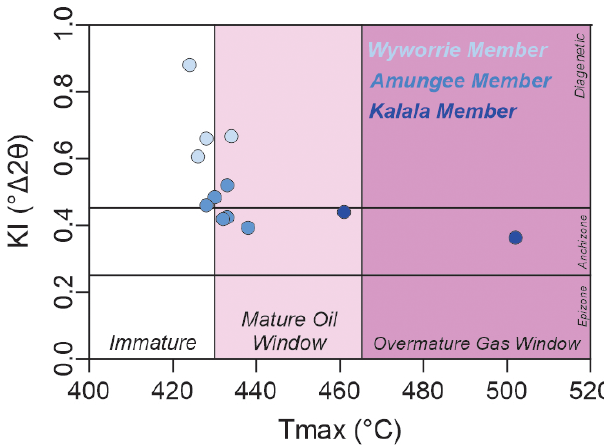
Figure 3. Covariation between T max values from pyrolysis analysis and illite crystallinity KI in the Velkerri Formation. An increase in T max coincides with a decrease in KI, suggesting that these proxies are both mainly sensitive to changes in